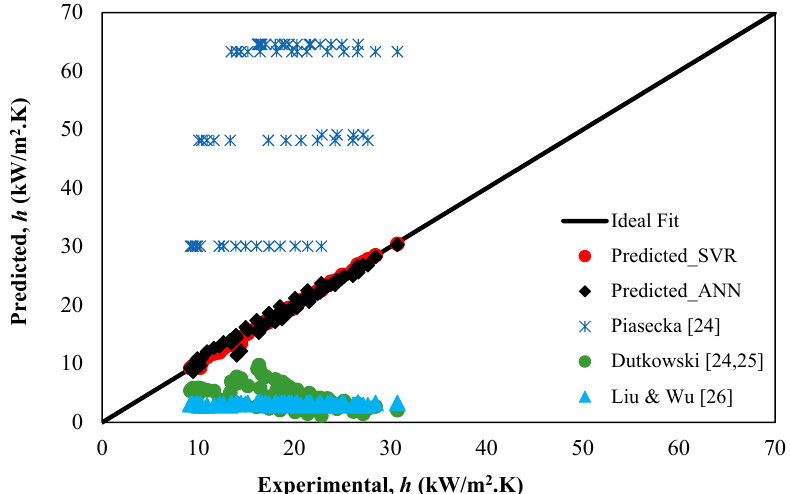
Figure 6. Performance comparison of AI-based models versus existing correlations for predicting the heat transfer coefficient on the test dataset.